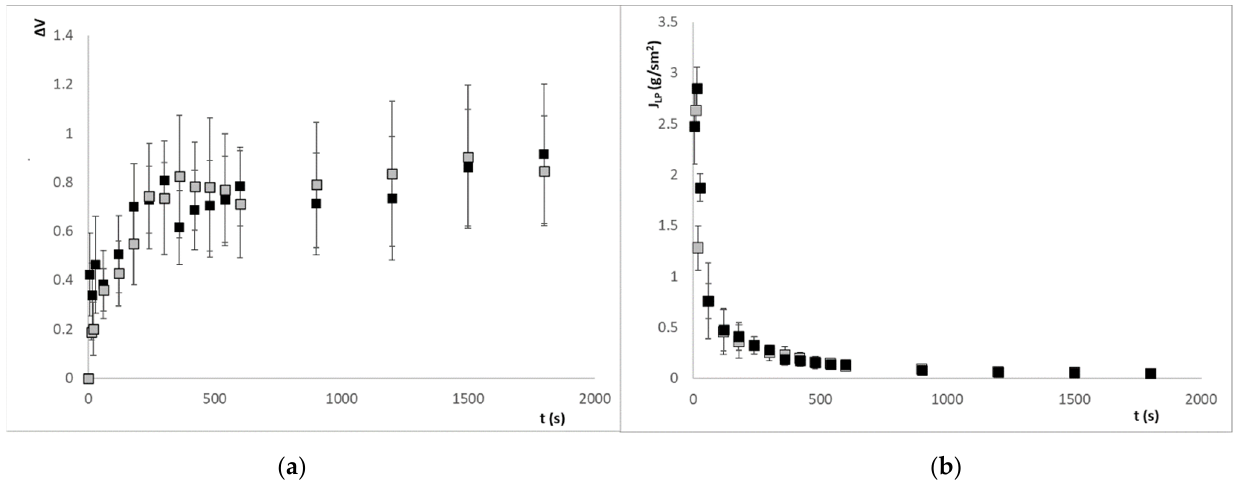
Figure 7. ( a ) Evolution of the volume variation of alginate beads with ascorbic acid; ( b ) Evolution of the liquid phase flux entering the calcium alginate beads with vitamin C. Symbol ■ refers to pH = 3 and ■ refers to pH = 4.7.